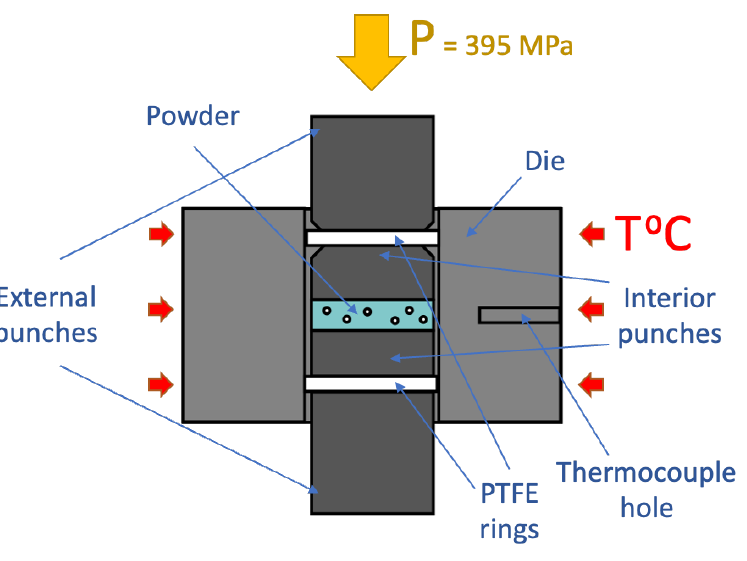
Figure 1. CS setup Figure 1. CS setup scheme. 145